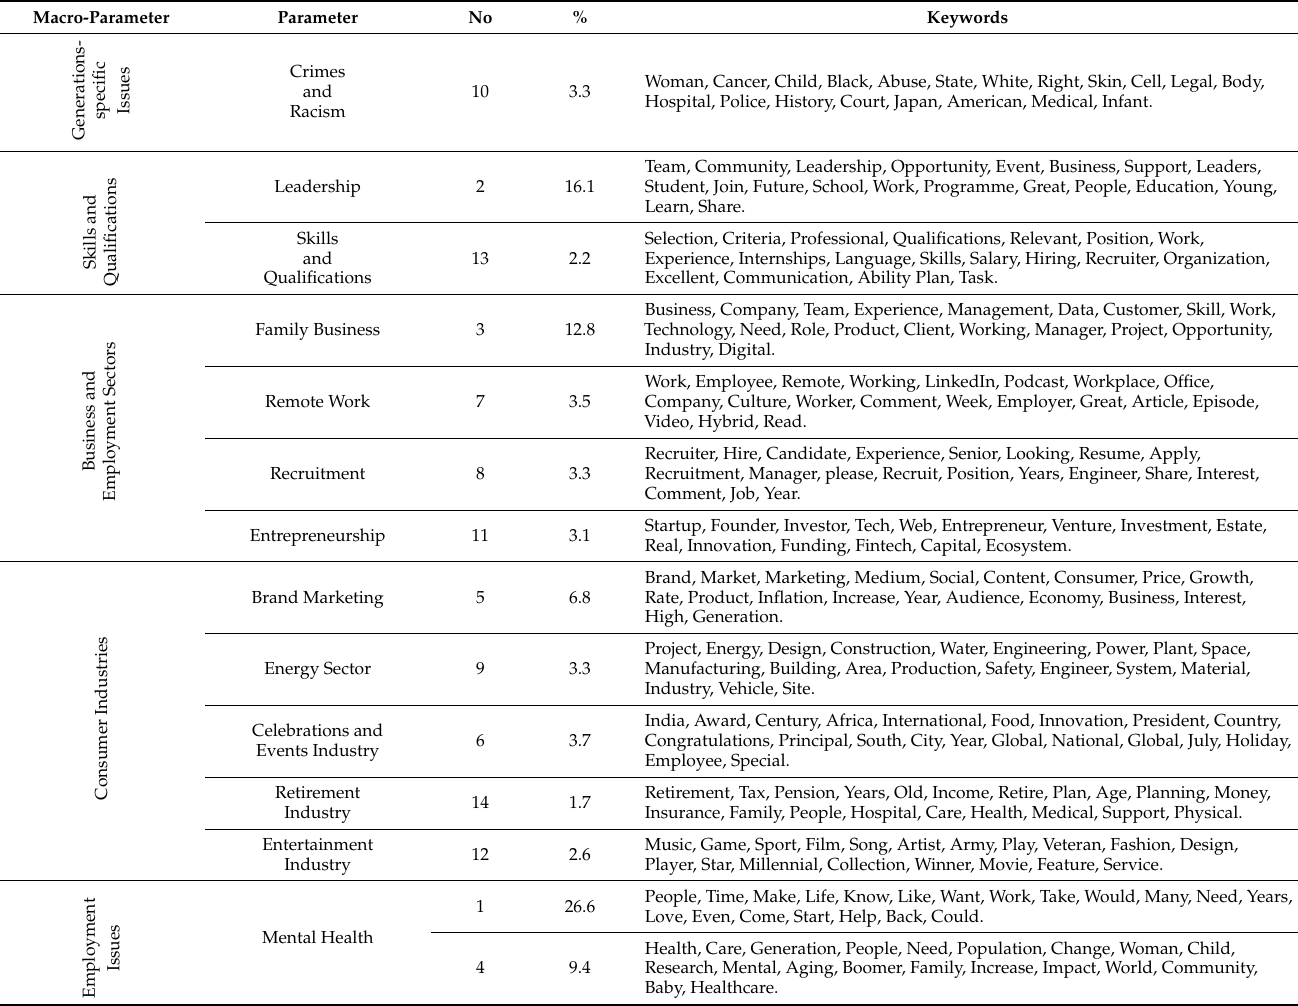
Table 2. Parameters and macro-parameters of labour market from a multi-generational